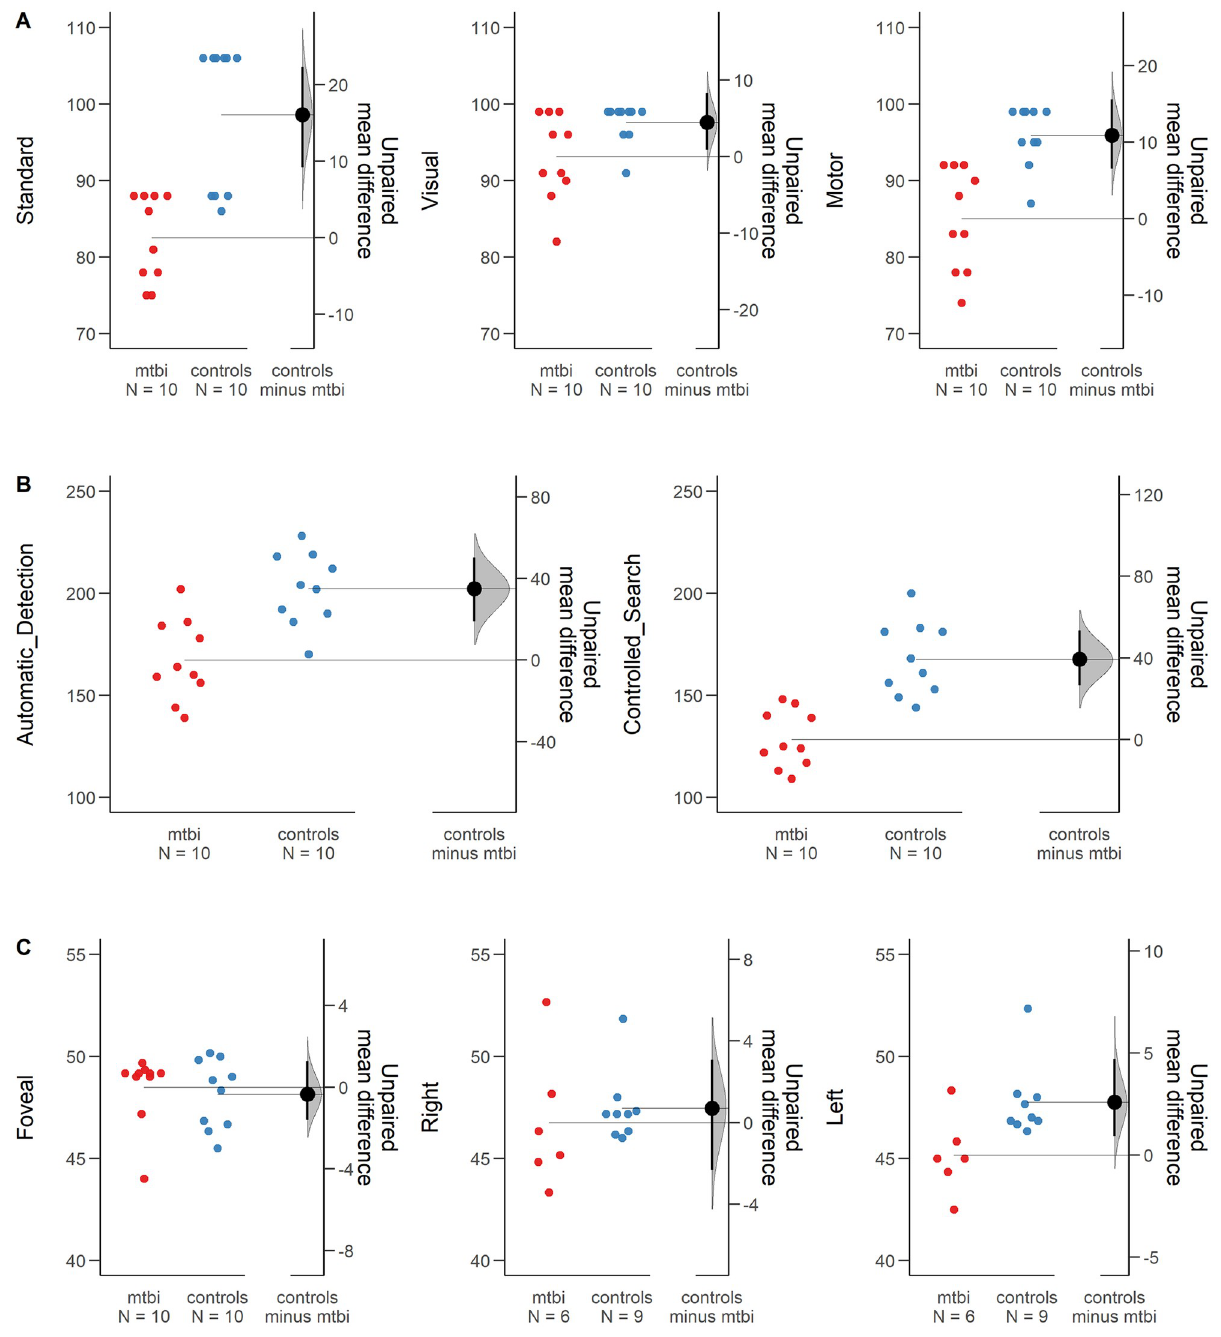
Fig 2. Visuo-motor, fine motor, form recognition (Visual), and attention skills assessed in mTBI and controls. (A) VMI-6 test scores indicated difficulties in the mTBI group as compared to the control group for all VMI-6 test speed scales (Error bars indicate standard error mean). (B) The mTBI group exhibited lower performances in both RSAT scales when considering the velocity of response. (C) The mean CFF threshold distribution for mTBI and control group across the visual field indicated difficulties in mTBI as compared to Controls when the stimulus is presented 13˚ Left position as compared to Foveal